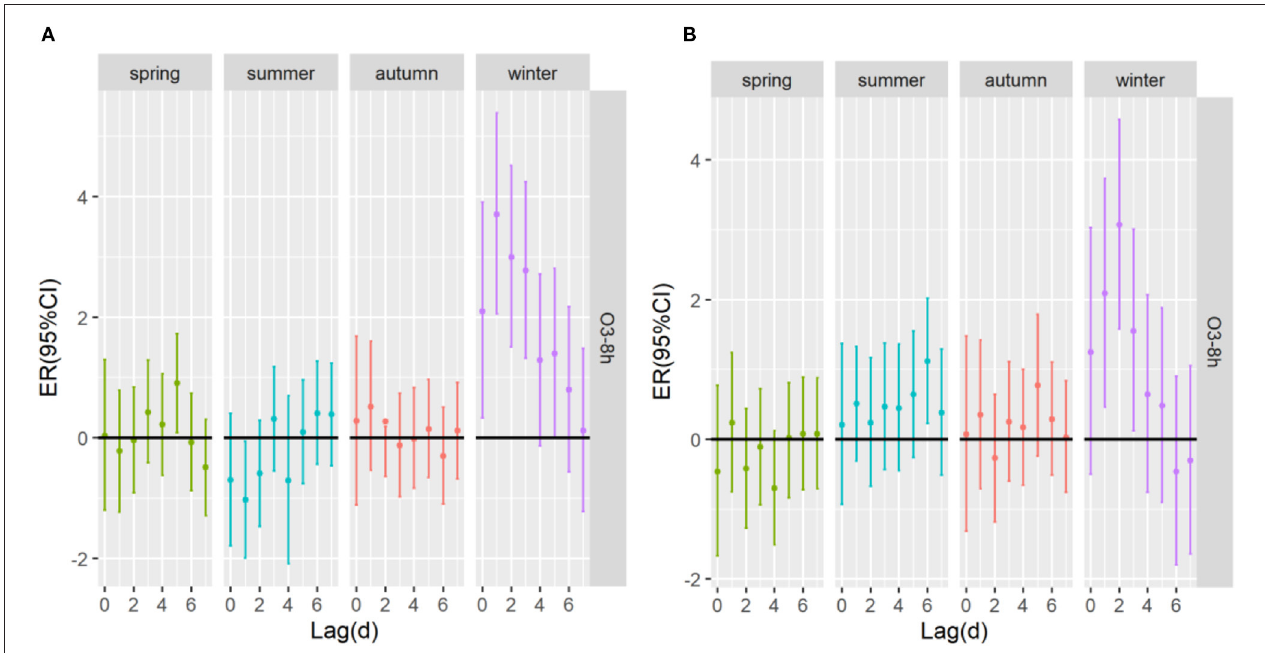
FIGURE 7 | The ER (95%CI) of mortality in season lag-response relationship associated with 10 µ g/m 3 increase of O 3 -8h concentration; (A) O 3 -8h lead to respiratory mortality; (B) O 3 -8h lead to cardiovascular